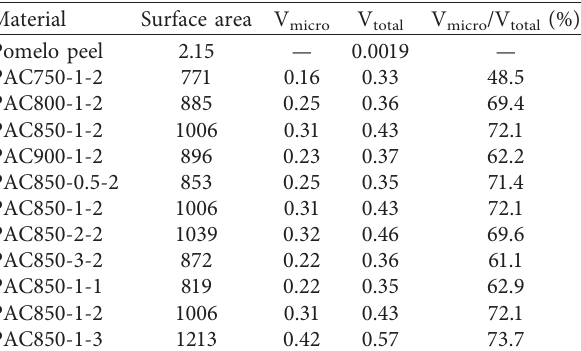
Table 2: Textural characteristics of PACs.